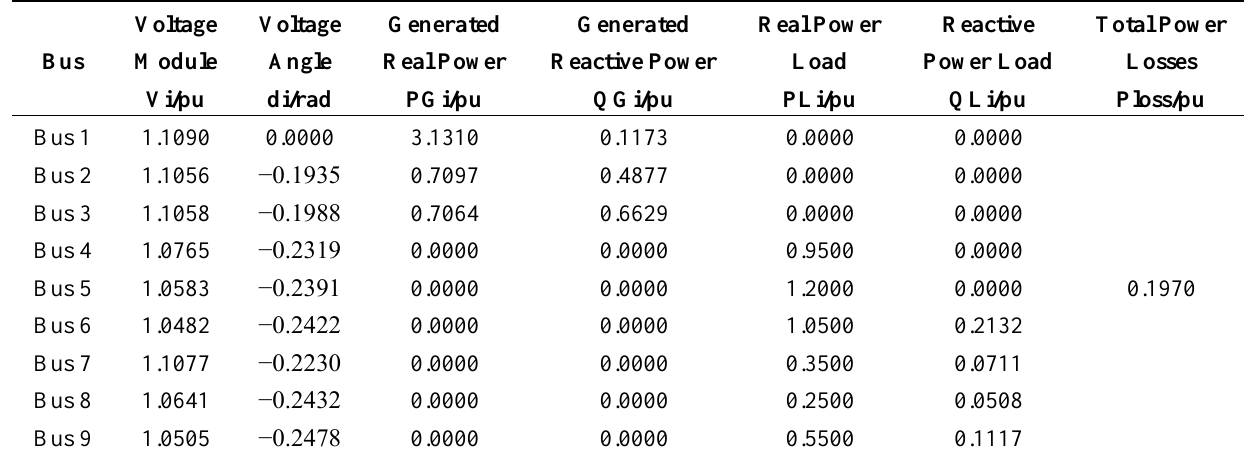
Table 10. Initial operating point.